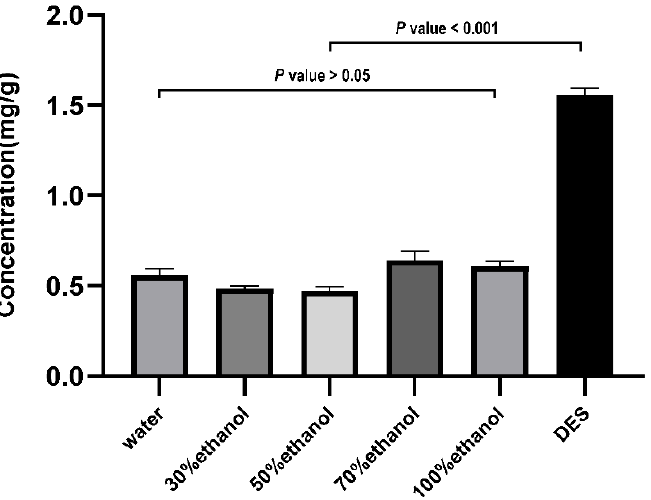
Figure 4. The efficiency of different solvents for the extraction of isofraxidin.